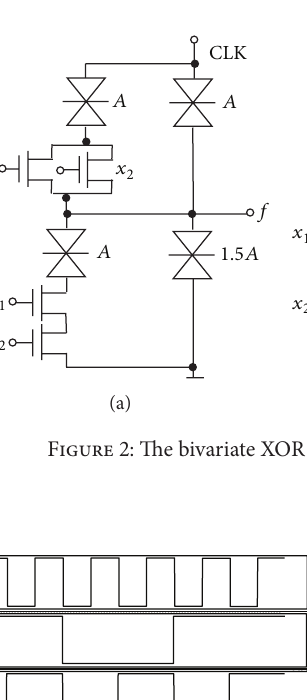
Figure 1: The universal threshold logic gate (UTLG), (a) schematic (b) symbol.